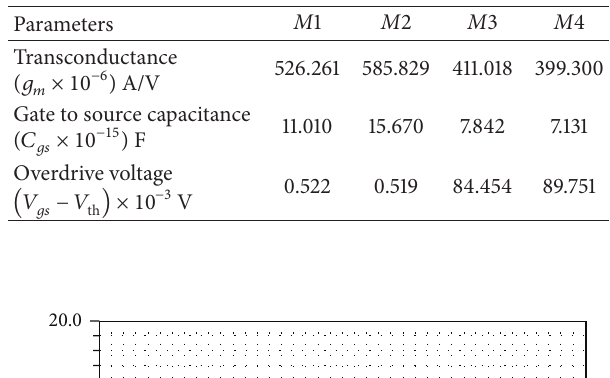
Table 2: Simulated circuit parameters.